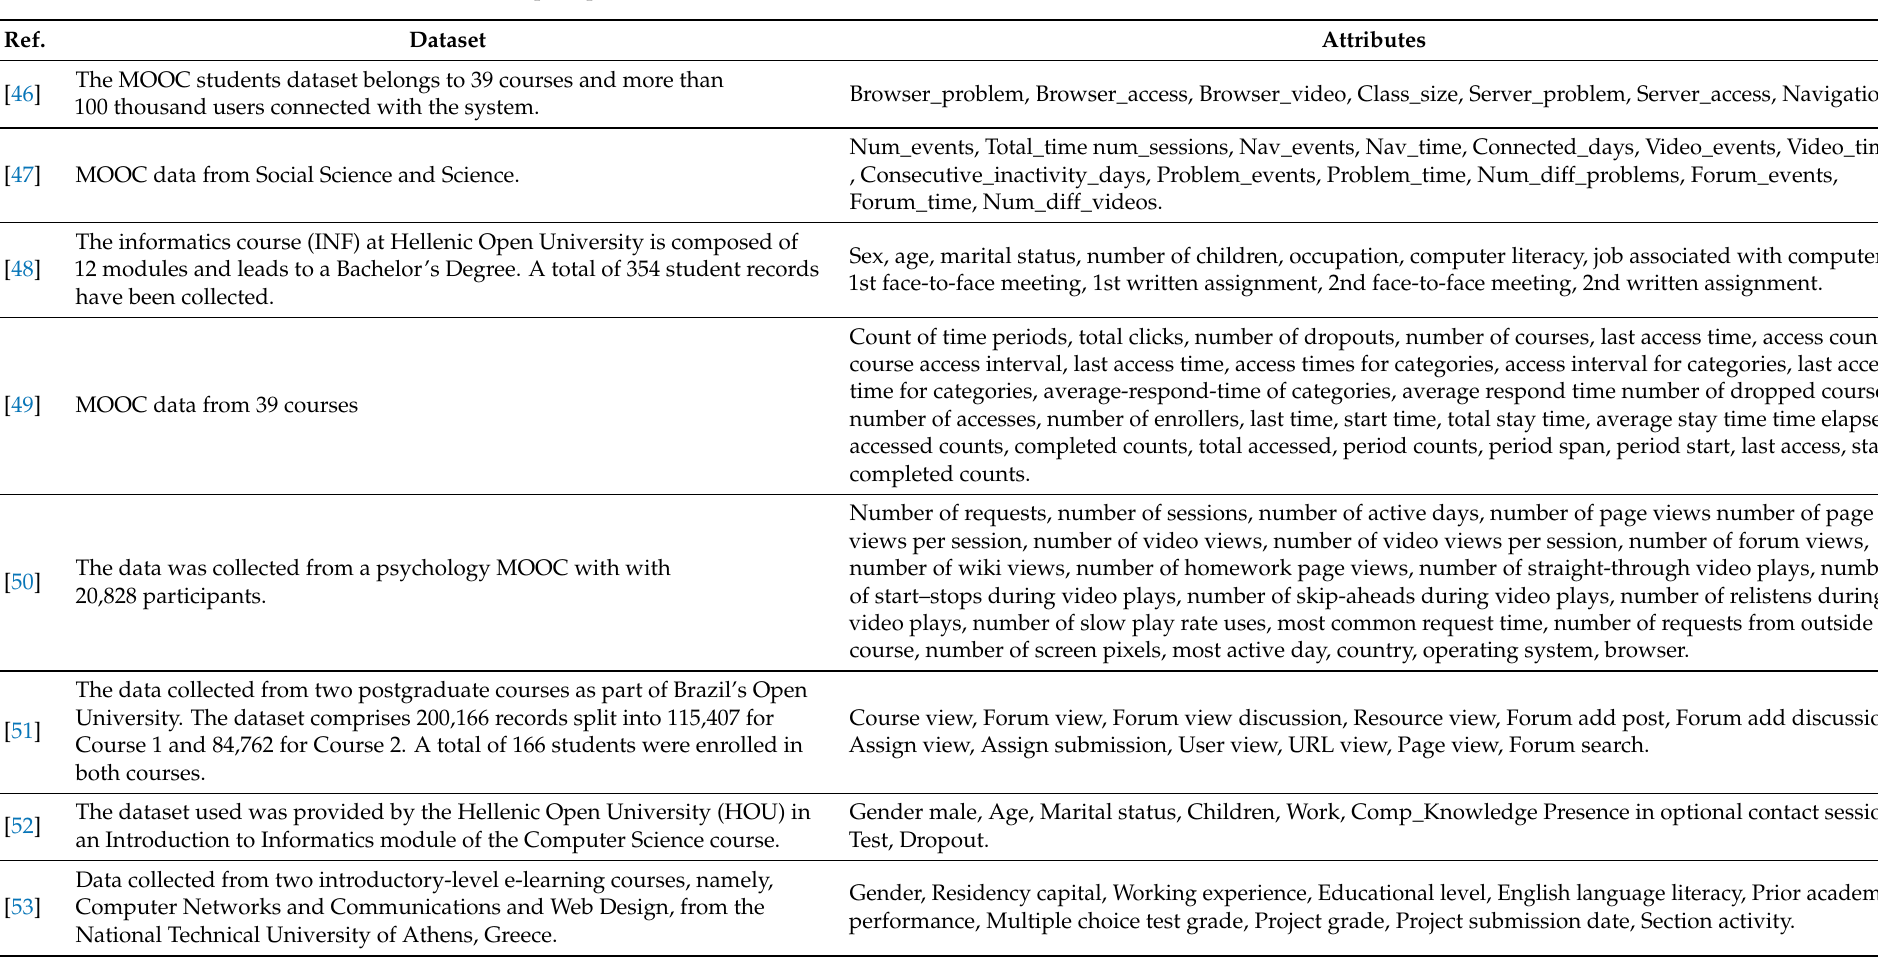
Table A1. Student dropout prediction dataset and attributes used to train ML